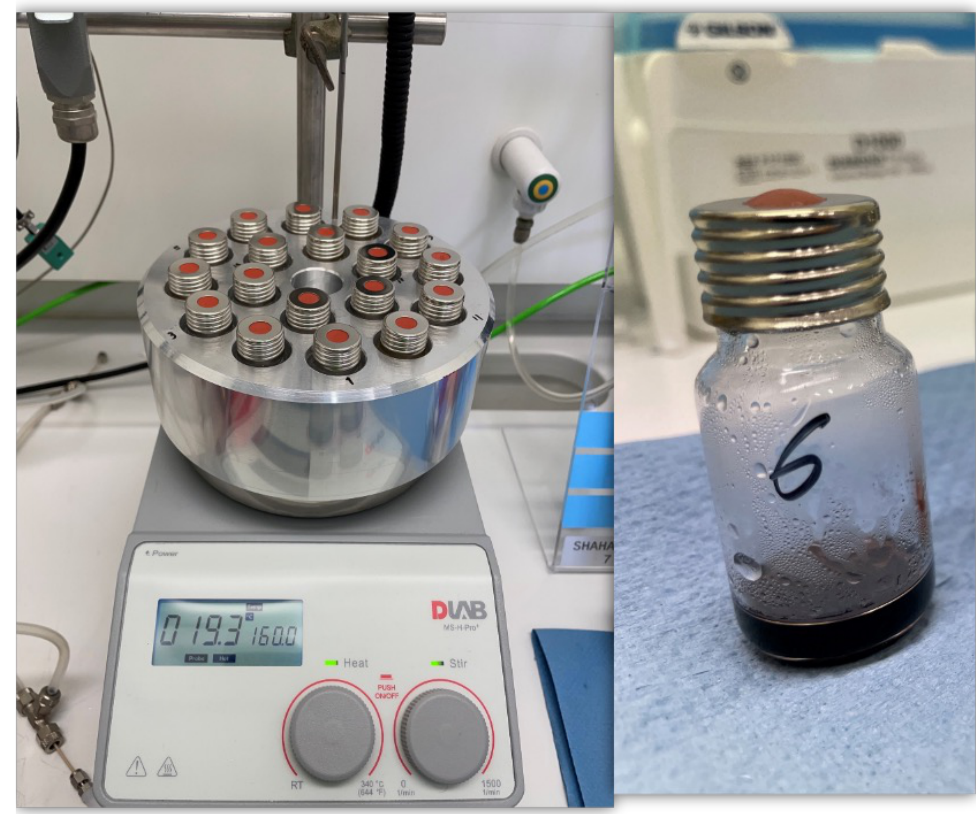
Figure A1. Autoclave heating block and setup were used in these